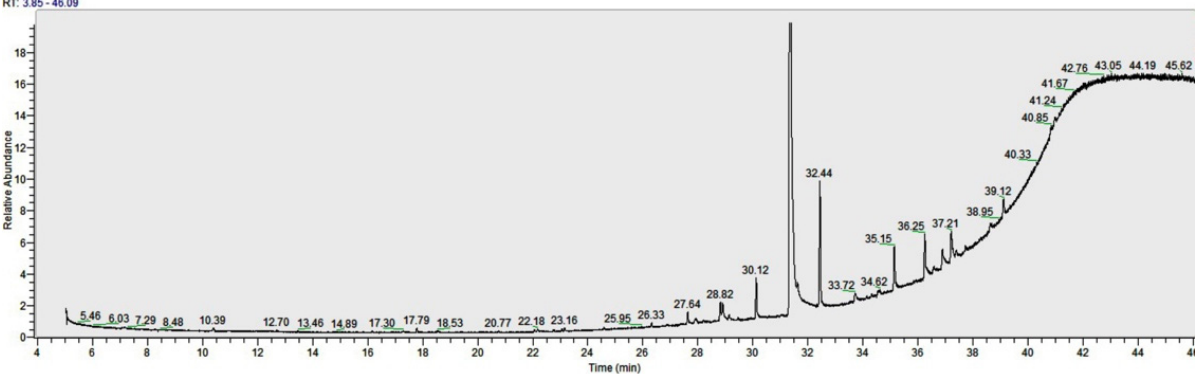
Figure 2. Representative Gas Chromatography—Tandem Mass Spectrometry (GC-MS/MS) chro- matogram. Table 1. List of identified compounds and accurate masses.